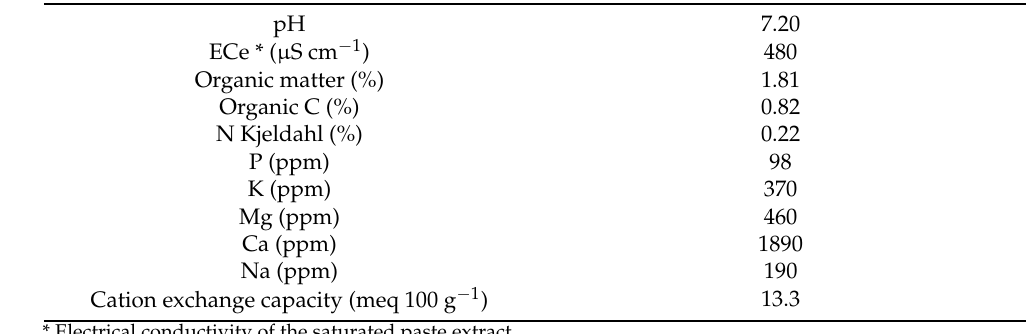
Table 1. Soil characteristics of trial